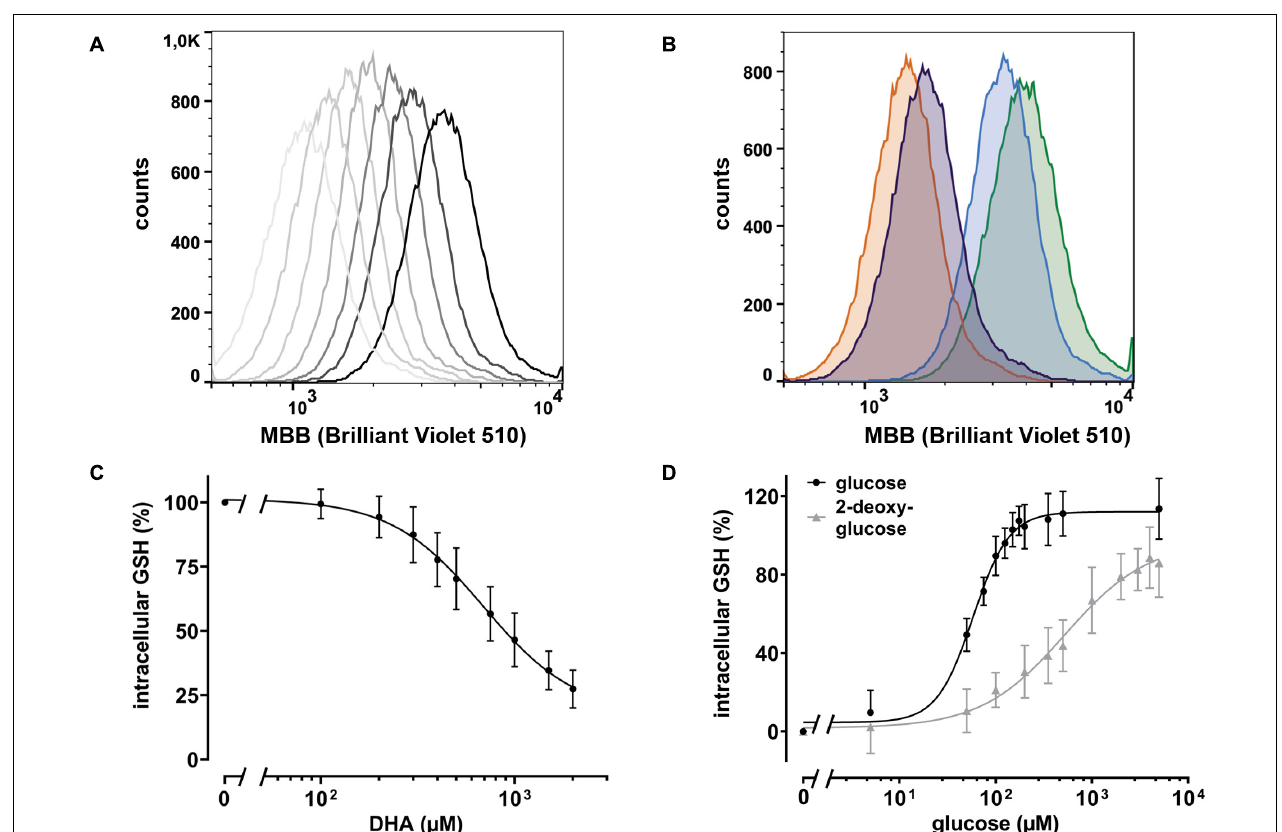
FIGURE 3 | DHA-dependent depletion of cellular glutathione (GSH) is rescued by glucose and 2 deoxy-glucose (2-DG). (A) Histogram of intracellular GSH after incubation with DHA (0.3–2.0 mM, dark to light gray). The black line indicates PBS control cells. (B) Histogram of dose dependent rescue of intracellular GSH upon incubation with 2 mM DHA (orange) in the presence of 100 µ M glucose (blue) or 100 µ M 2-DG (violet) versus PBS control cells (green). (C) Erythrocytes ( n = 11) were treated with various amounts of DHA for 15 min. Cells were then washed and incubated with the fluorescent thiol reagent monobromobimane (MBB) for 10 min. Afterward cells were centrifuged, resuspended in PBS, and processed for flow cytometry. Cells treated for 30 min with 3 mM 1-chloro-2,4-dinitrobenzene (CDNB), a glutathione-S-transferase ρ substrate capable of depleting 96% of cellular GSH within 30 min, were used as negative, cells in PBS as positive controls. MFI values of DHA-treated samples are given as percentages. Data were normalized to the MFI of positive (100%) and negative controls (0%), respectively. (D) Erythrocytes ( n = 11) were treated with 2 mM DHA in the presence of indicated concentrations of glucose or 2-DG for 15 min at RT, diluted, and incubated with the fluorescent thiol reagent MBB for 10 min. Afterward, cells were centrifuged, resuspended in PBS, and analyzed by flow cytometry. MFI values are given as percentages after normalizing the data to the MFI of cells pretreated with PBS (100%) or 2 mM DHA without glucose or 2-DG (0%), respectively. Mind that cells treated with 2 mM DHA in the presence of > 125 µ M glucose have higher intracellular GSH levels than cells treated with PBS